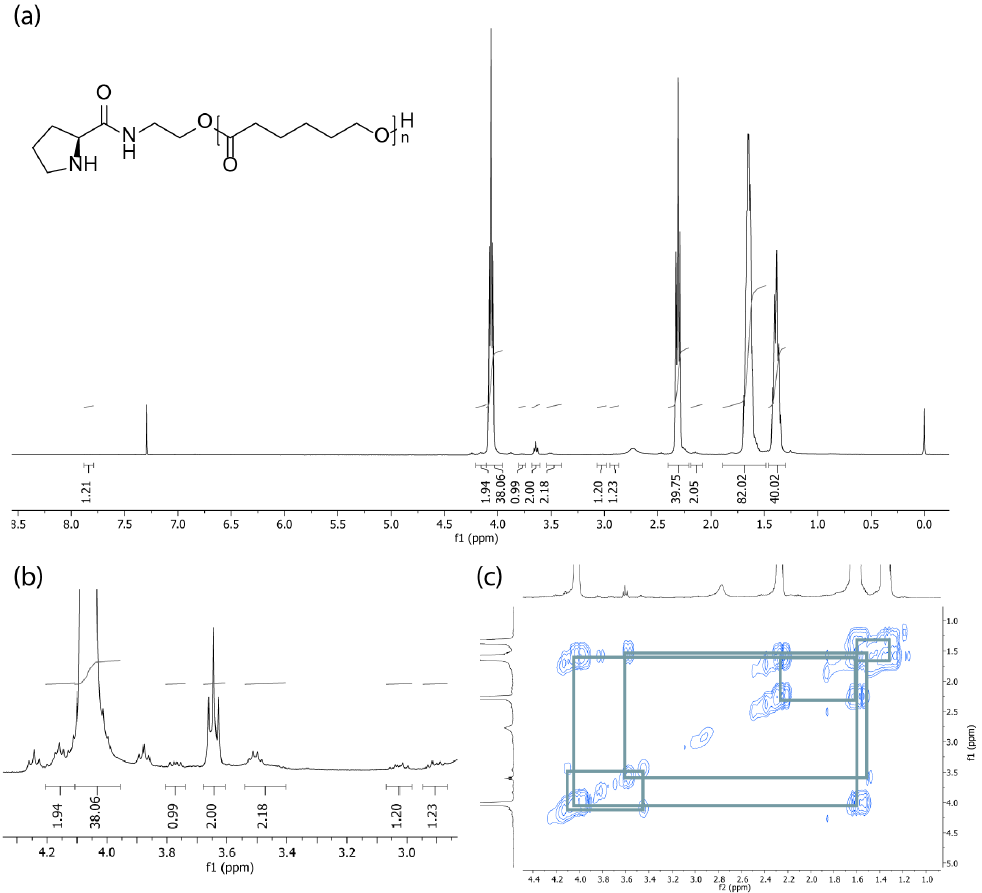
Figure 2. NMR analysis of compound PCL-06 : ( a ) 1 H NMR showing the proportion between polymer and initiator signals; ( b ) magnification of the spectrum in ( a ) to better evidence the initiator signals; ( c ) magnification of 1 H- 1 H NMR COSY to exhibit the coupling between polymer chain signals and the characteristic coupling patterns of the pyrrolidine derivatives.